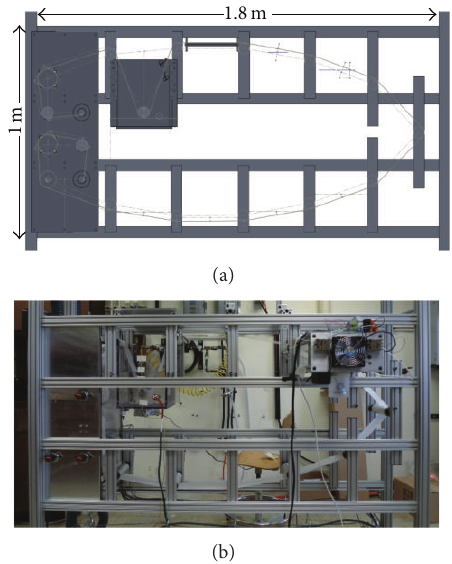
Figure 2: Overview of the membrane coating machine.